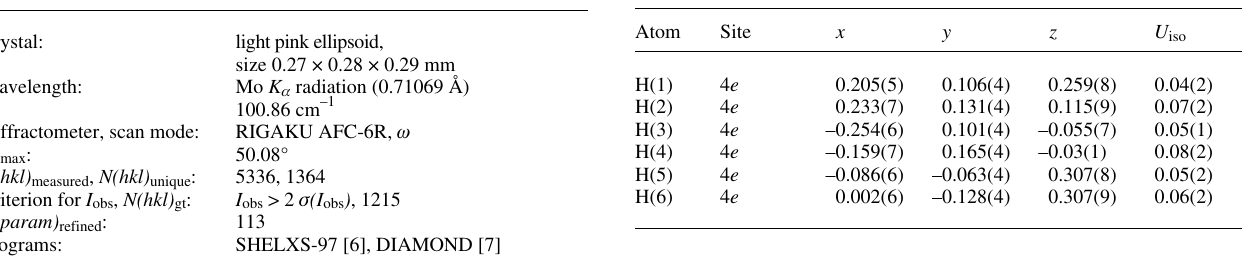
Table 4. Data collection and handling. Table 5. Atomic coordinates and displacement parameters (in Å 2 ) .